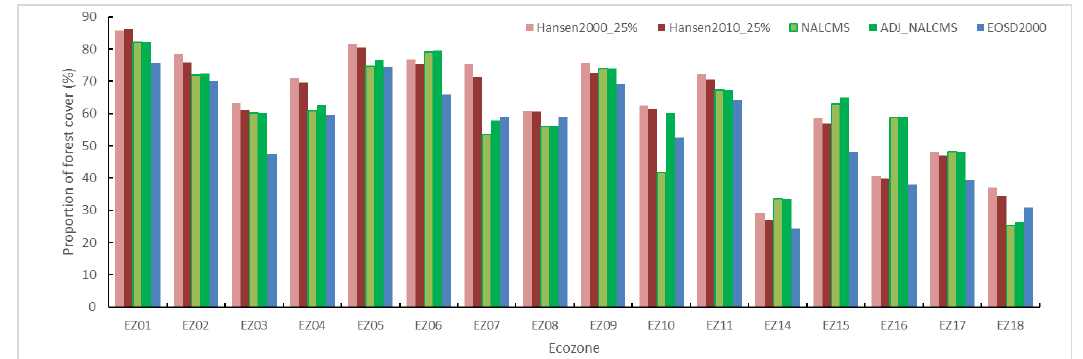
Figure 2. The proportion of forest cover from different datasets for 16 ecozones dominated with forest. Hansen2010 is obtained from Hansen2000 plus forest loss/gain during 2000-2010. ADJ_NALCMS is the same as NALCMS except that it includes wetland-treed pixels. See text for details.